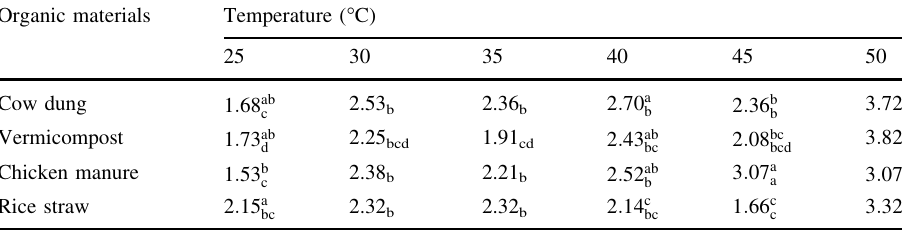
Table 5 Interaction effect of organic materials and temperature on C decrease (%) at 30 days of incubation